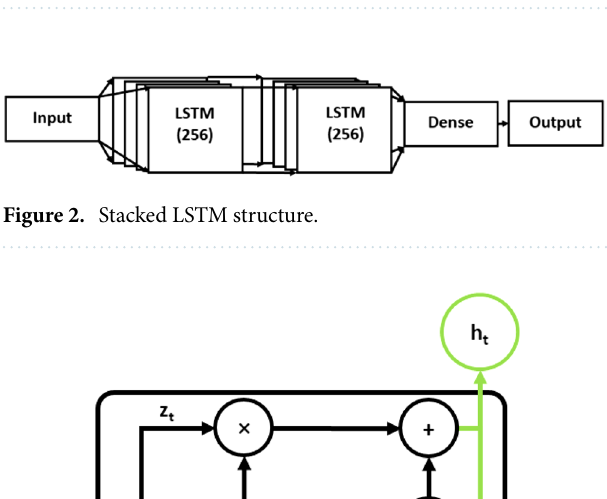
Figure 1. Networks of the LSTM unit.